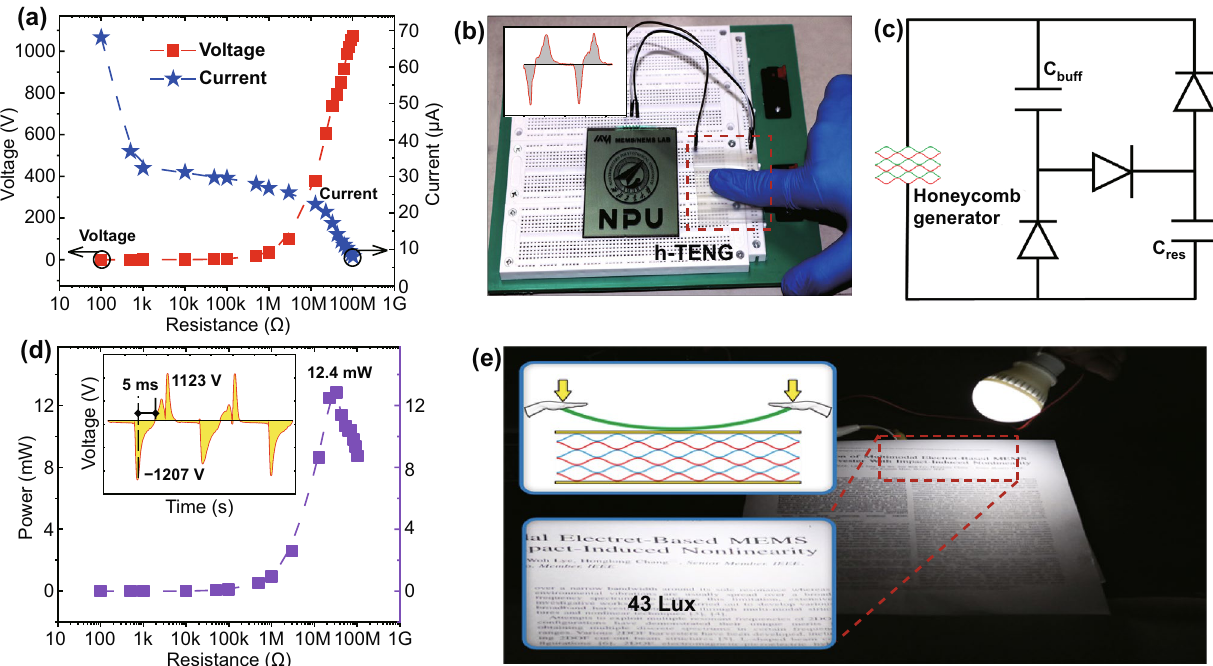
Fig. 4 a Output voltages and currents of h-TENG with different load resistances by hand tapping. b Lighten up 75 × 55 mm 2 LCD with h-TENG by finger touching. c Bennet’s doubler conditioning circuit for driving external electronics. d Output power optimization at different load resist- ances with hand tapping. e Light intensity of globe bulb up to 43 lx obtained by continuously tapping the h-TENG for ten times with a